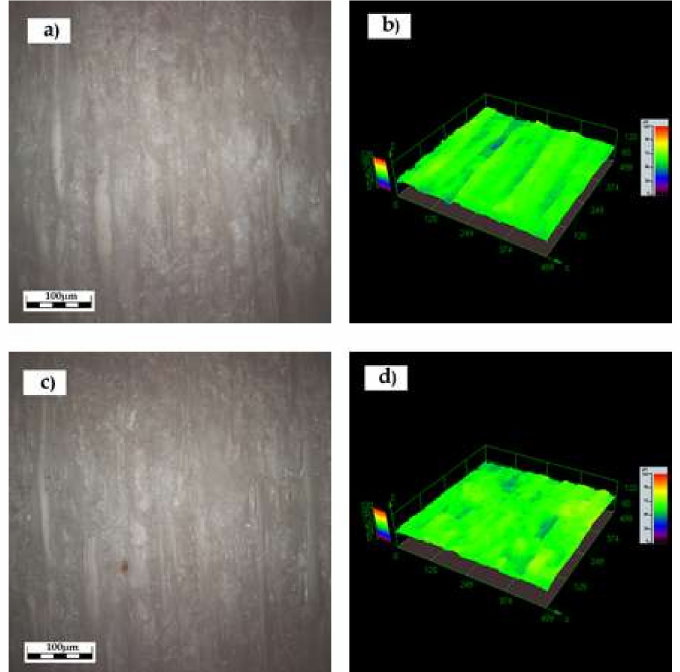
Figure 6. Optical profilometry images corresponding to the sample treated with 5%-immersion PVBVA. ( a ) and ( b ) show the 2D and 3D images of the sample before treatment and ( c ) and ( d ) the corresponding ones upon the treatment with the 5% PVBVA solution at 555 × .